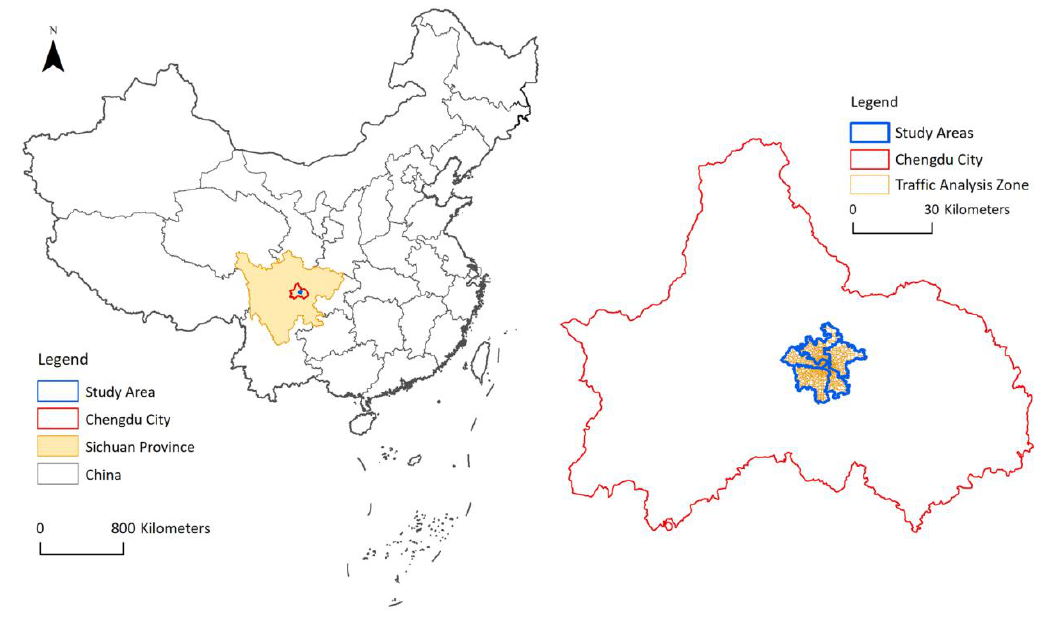
Figure 1. Study area of our research.